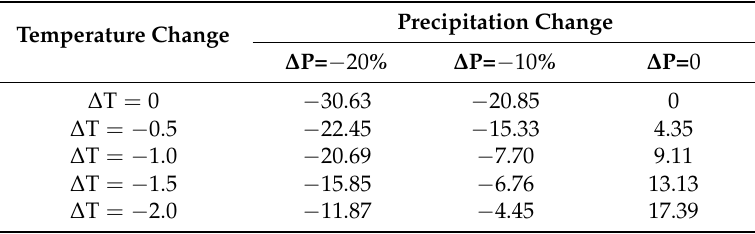
Table 11. Response of runoff to simultaneous decrease in temperature and